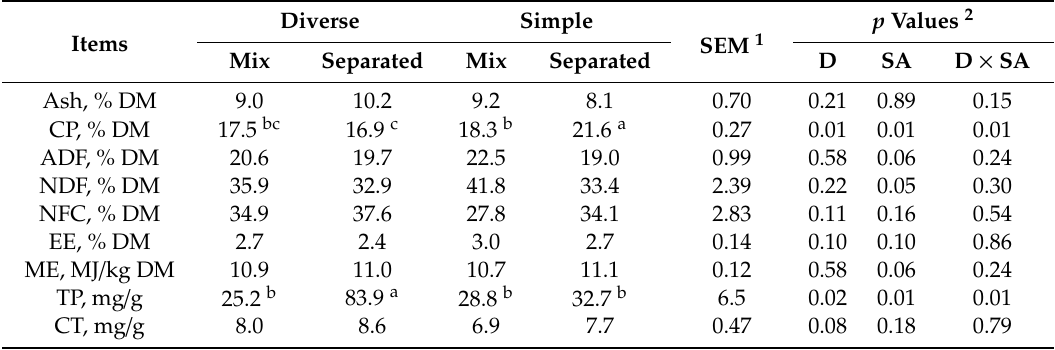
Table 3. E ff ect of pasture diversity (diverse or simple) and spatial arrangement (mix or separated) on nutritive value of